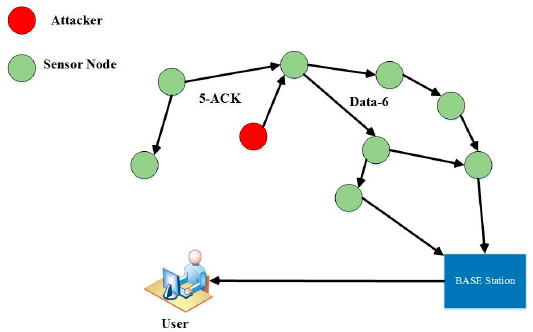
Figure 19. Acknowledgment spoofing attack on WSN [95,96].